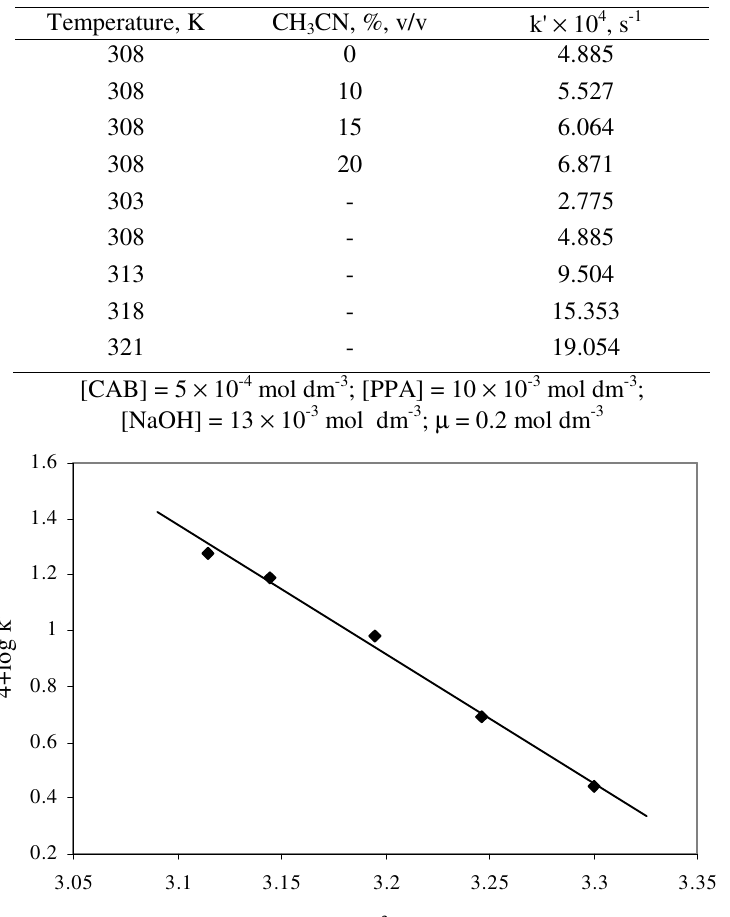
Table 3. Proton inventory studies for the oxidation of PPA in H